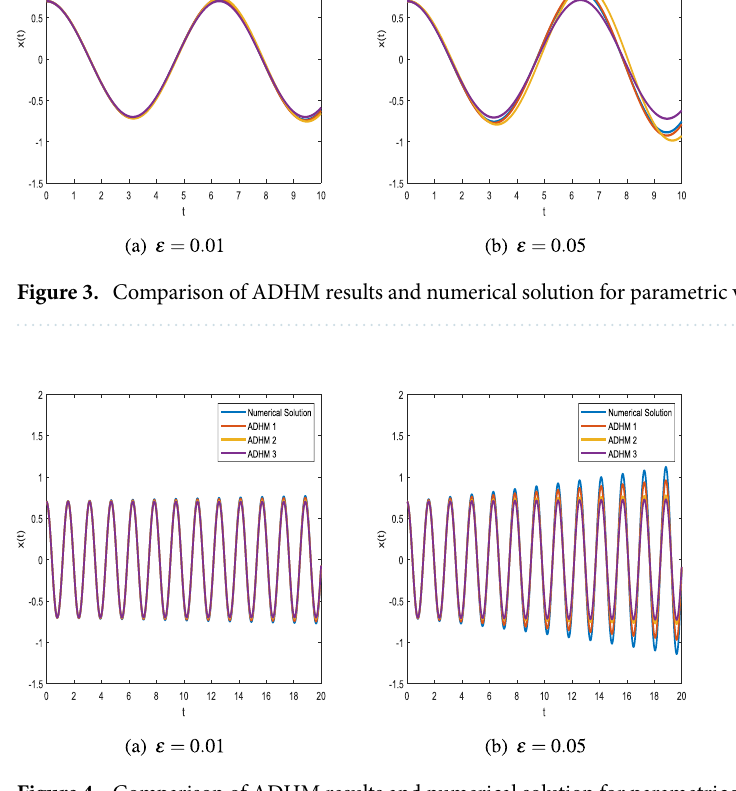
Figure 4. Comparison of ADHM results and numerical solution for parametric values x 0 = 0.5 and ω = 4 .